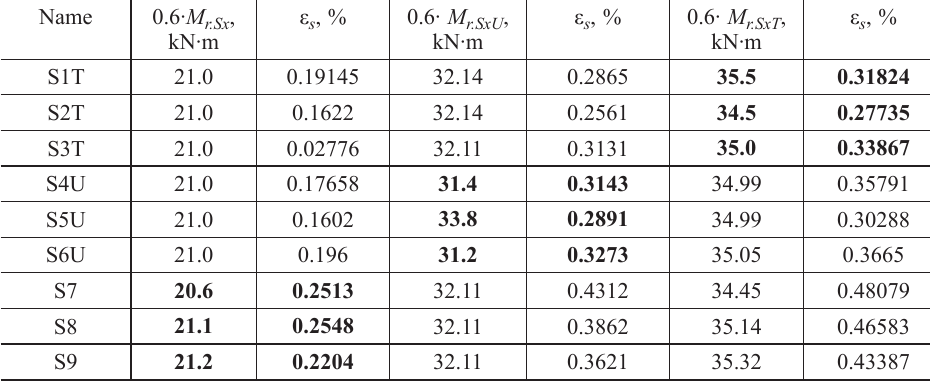
Table 6. Strains of the layer with the tensioned steel bar when M = 0.6· M r